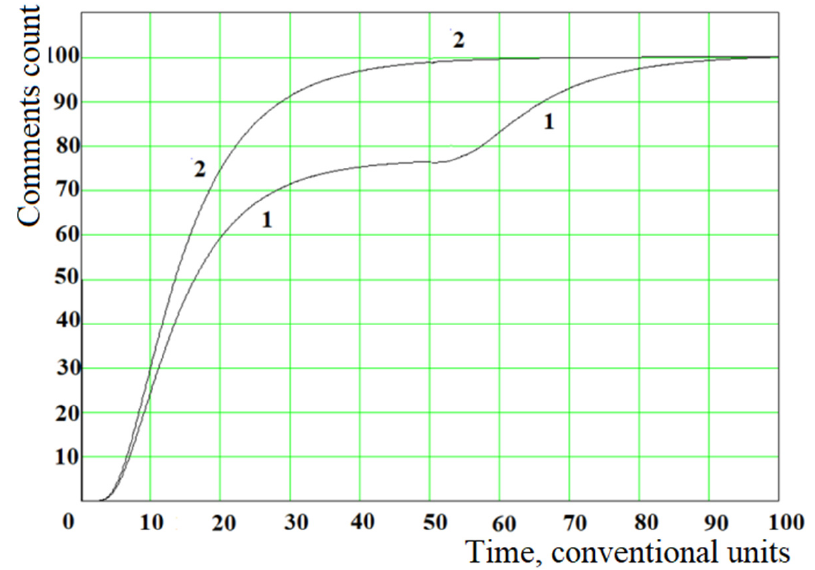
Figure 12. Dynamics of changes over time in the number of comments on the news in the simulation model based on the Fokker-Planck equation, considering two parallel processes.